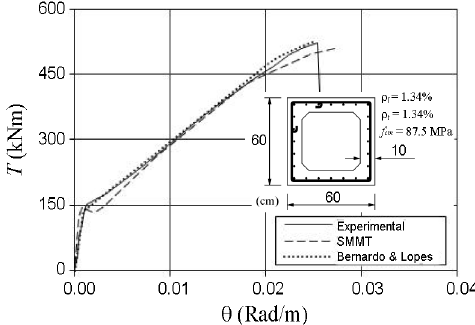
Fig. 19. T – θ curves for Beam C5